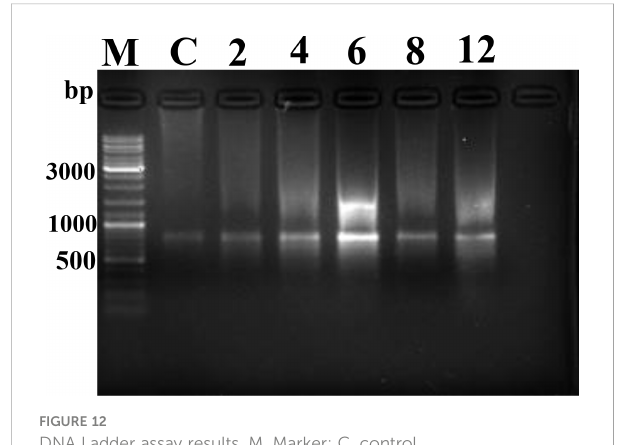
FIGURE 12 DNA Ladder assay results. M, Marker; C, control.